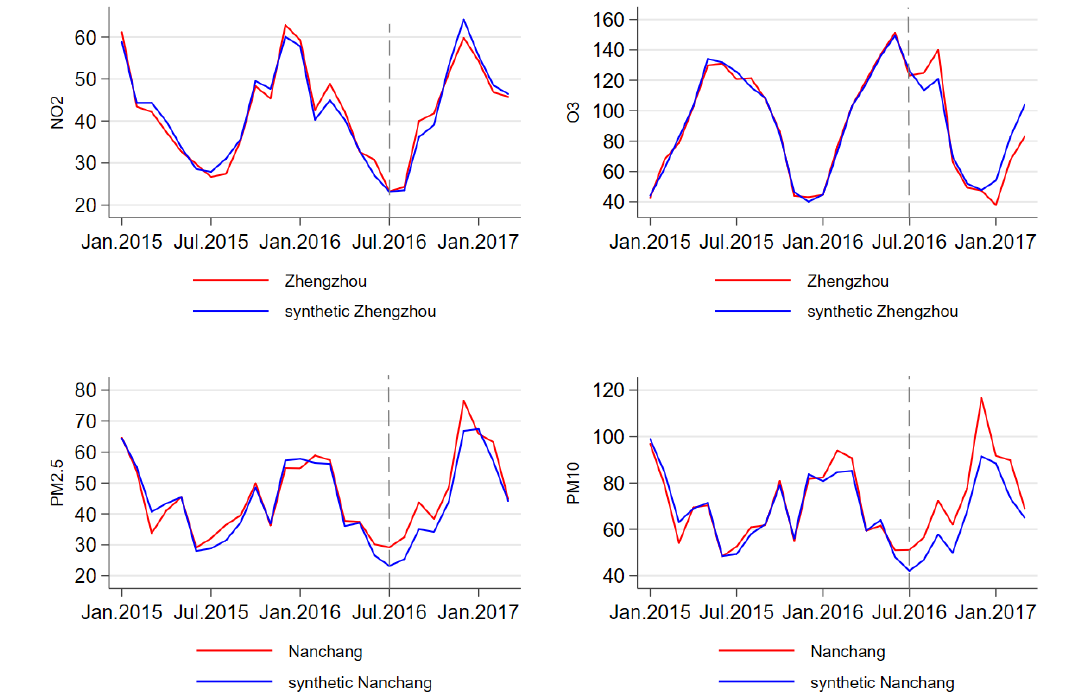
Figure 10. Individual pollutants in treatment regions and synthetic